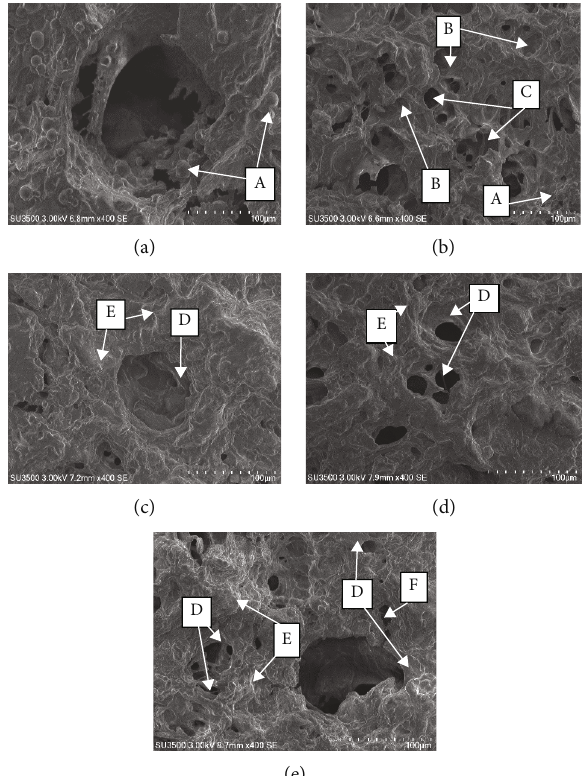
Figure 1: Microstructural pro fi le of sausages at di ff erent levels (magni fi cation × 400). (a) 0%; (b) 1% SFG; (c) 2% SFG; (d) 2% BCG; (e) 3% SFG; A=microorganism; B=semicircular hole as a place for unbound fat deposition; C=hole that resembles a pore due to the presence of free water; D=gelatin solution; E=meat fi ber; F=cracked sausage surface.